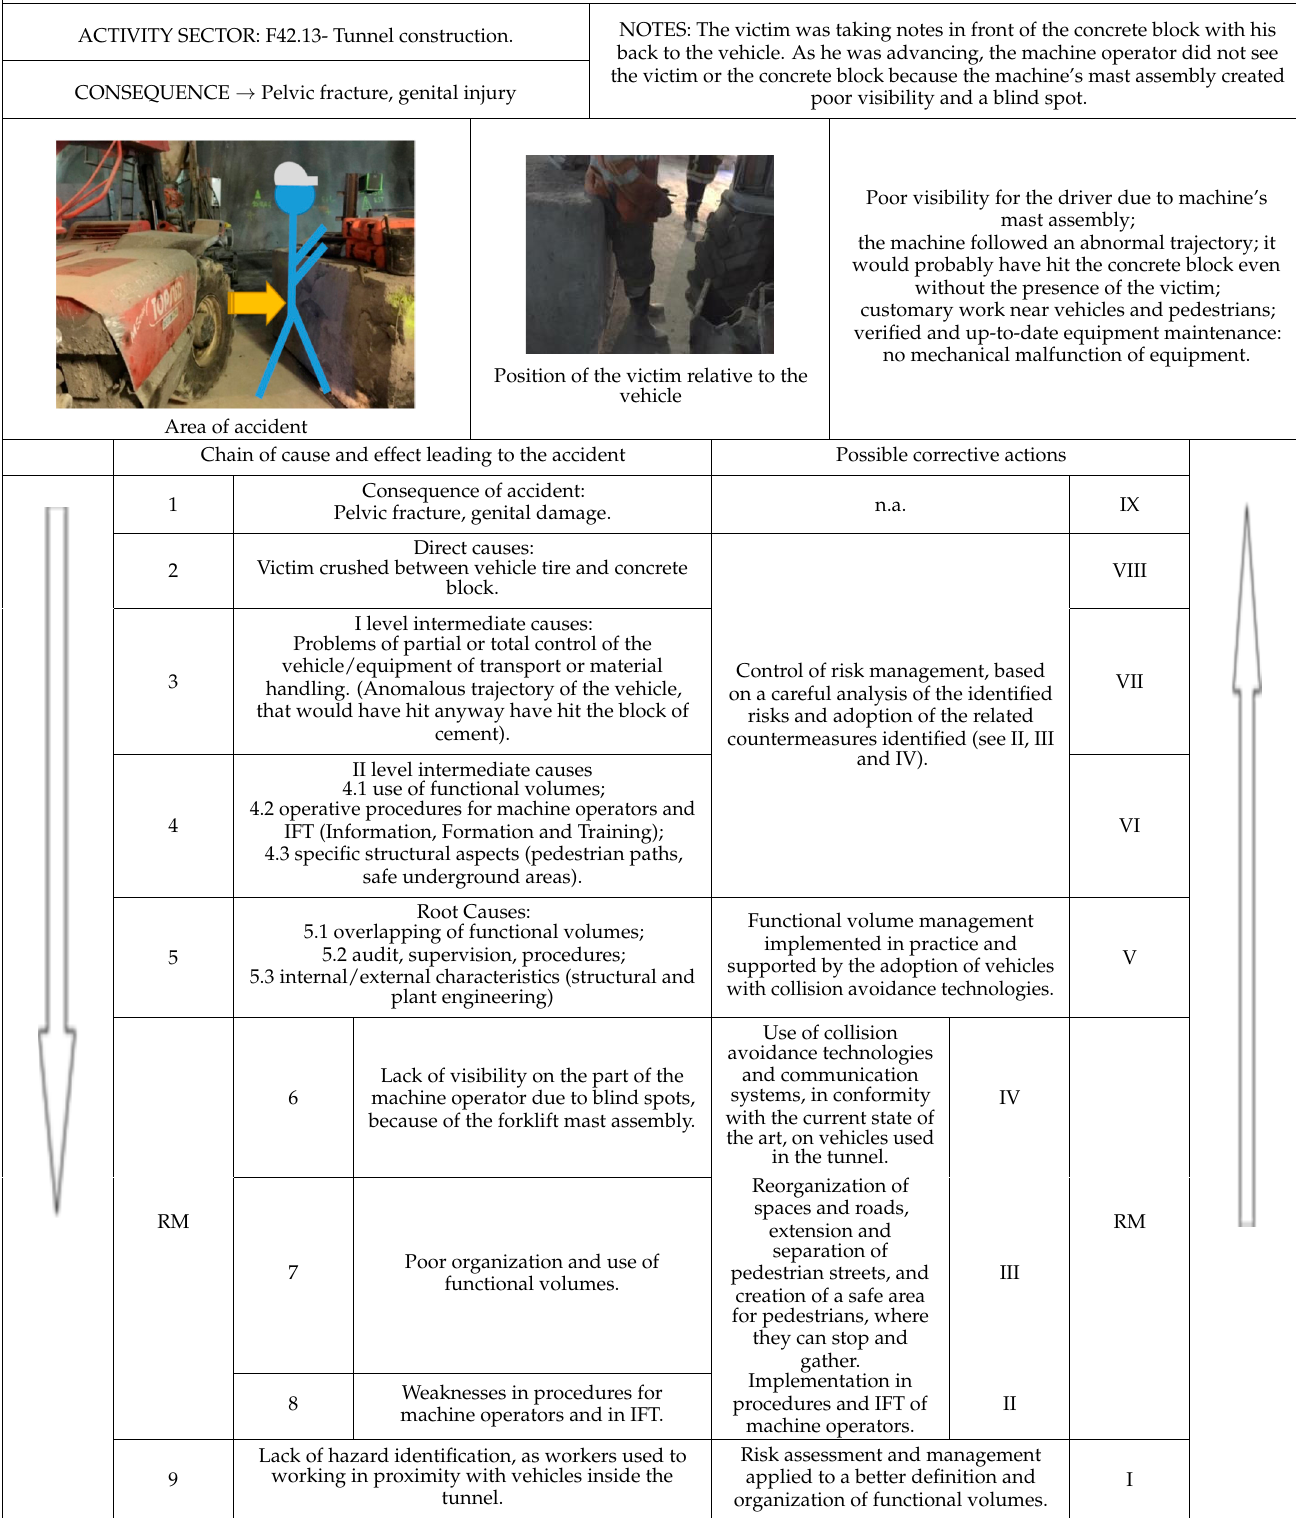
Table 3. Example of application of the Computer aided Cause Consequence for Prevention (CCCP) approach on a real accident case in the reference